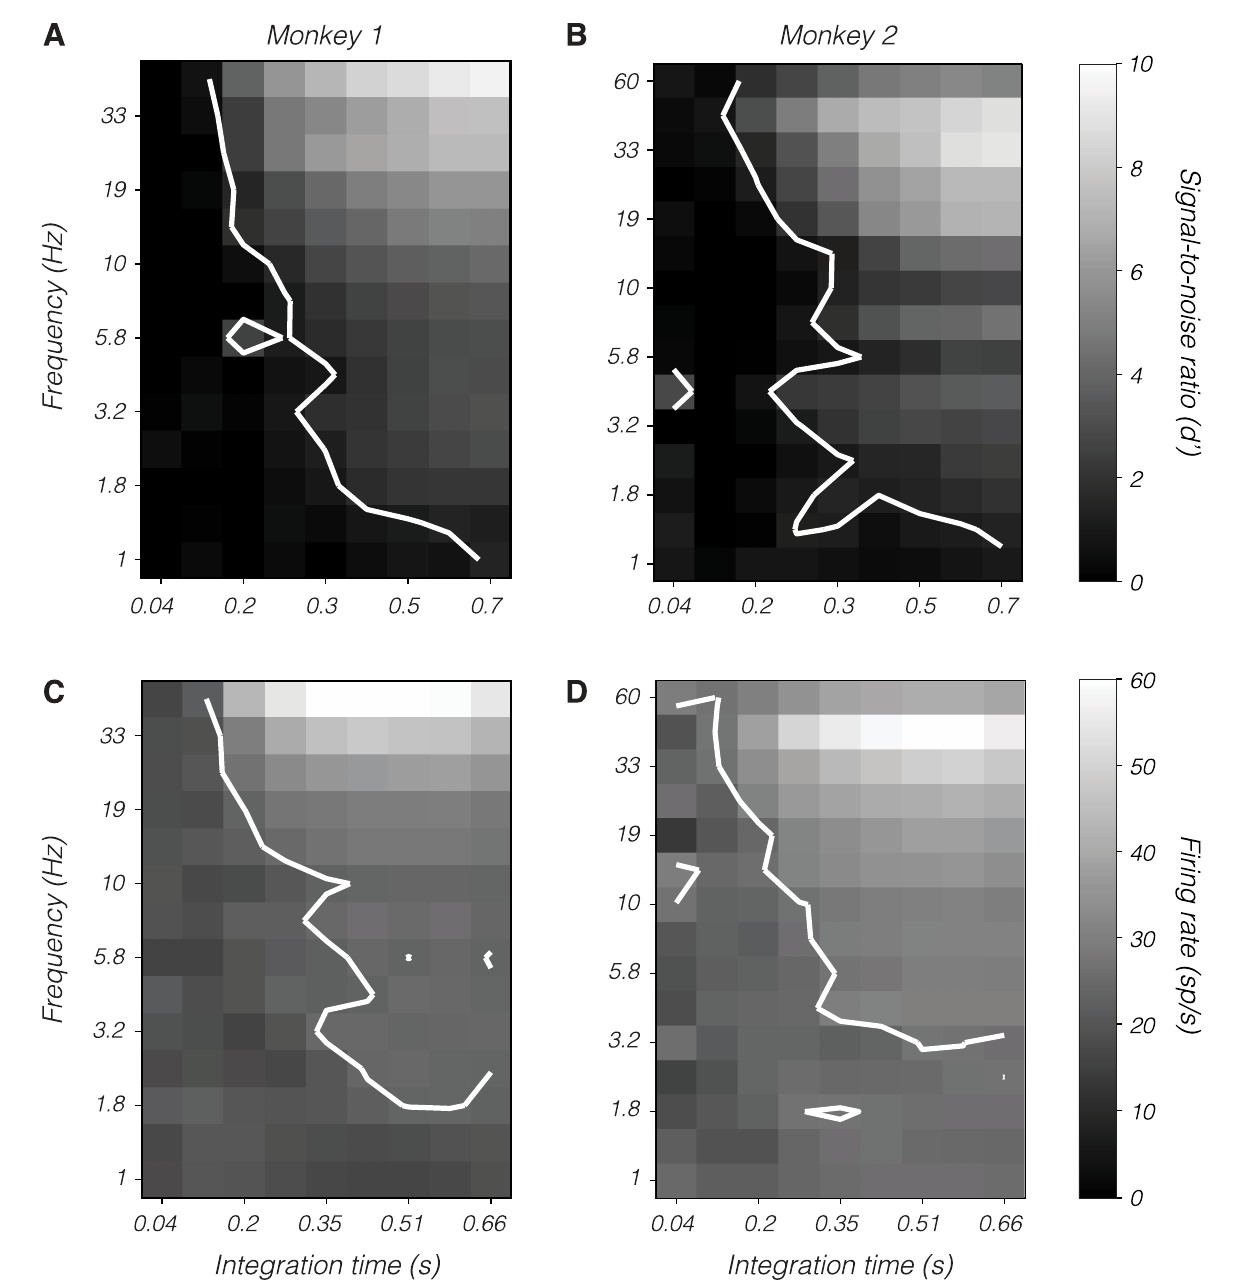
Fig 8. Magnocellular population signal-to-noise ratio, d 0 (A and B), and mean firing rate (C and D) as a function of temporal frequency (ordinate) and integration time from stimulus onset (abscissa). Data from monkey 1 appear in (A) and (C), and data from monkey 2 appear in (B) and (D). Contours in (A) and (B) indicate the locus of points at which d 0 = 1.27. Contour in (C) is at 17 spikes/s. Contour in (D) is at 16 spikes/s. These were selected to maximize the similarity of contours between (A) and (C) and between (B) and (D). Data are available at